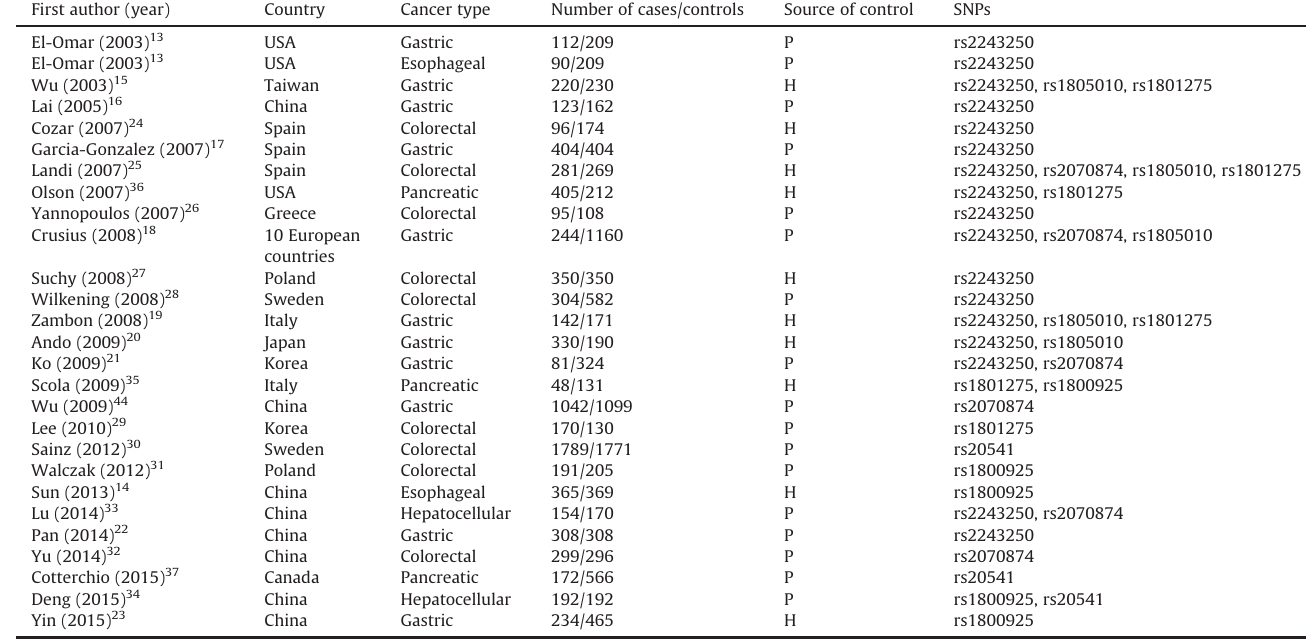
Table 2 Characteristics of the studies included in the